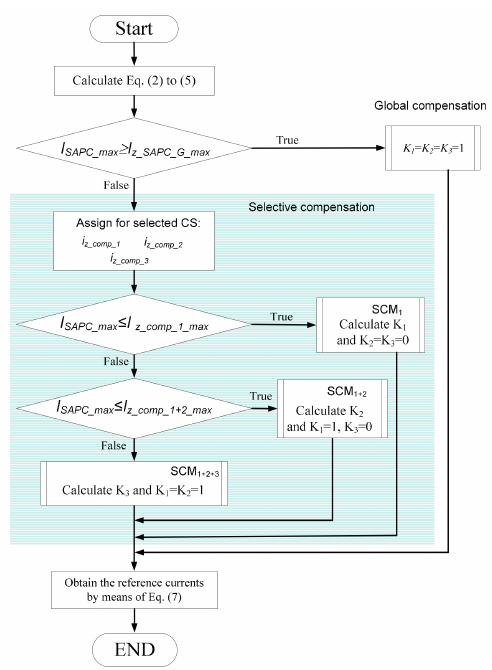
Figure 2. Flowchart of the main algorithm.